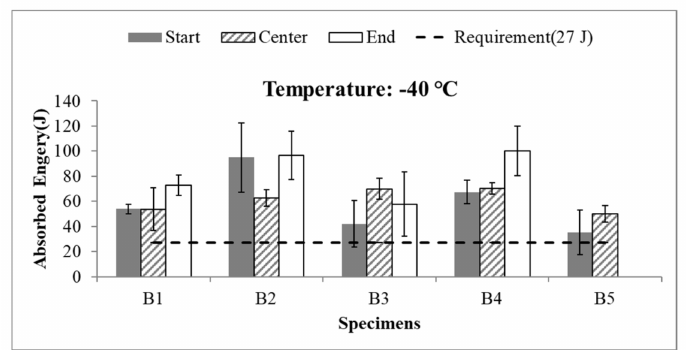
Figure 9. Results of Charpy impact test for start and end part of butt-welding